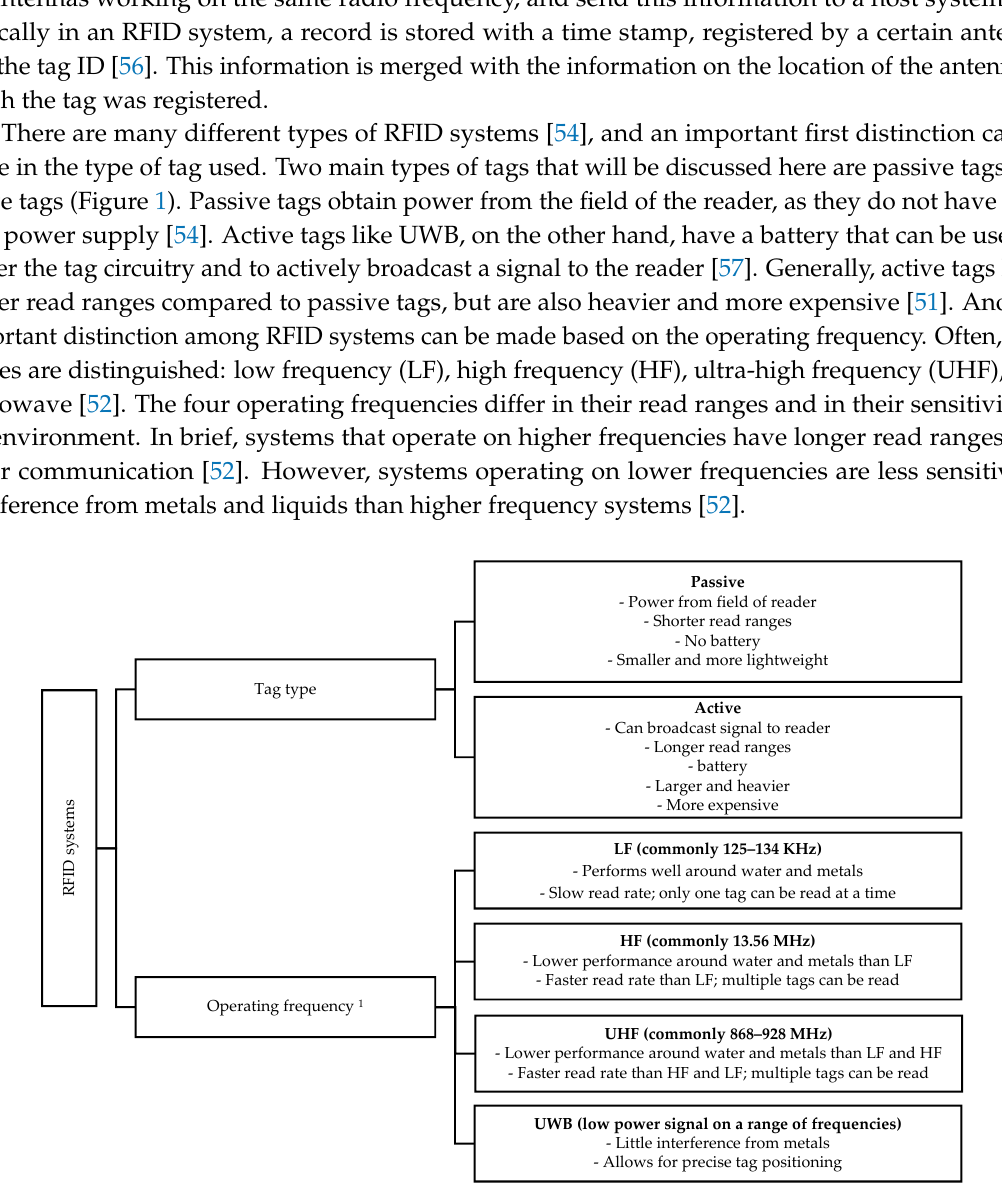
Figure 1. Overview of different radio frequency identification (RFID) systems and their main characteristics (based on [51,52,54,57,58]) 1 . Microwave frequencies are excluded here, as these are not commonly used for animal tracking. LF: low frequency; HF: high frequency; UHF: ultra-high frequency; UWB: ultra-high